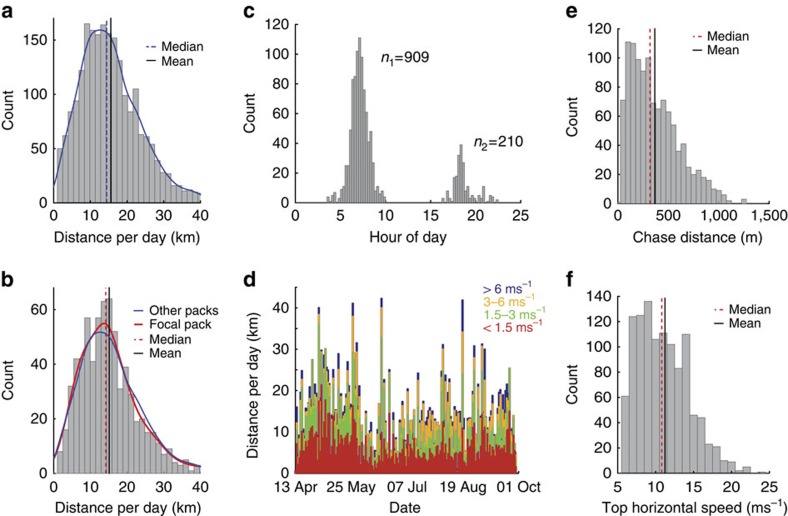
Detailed analysis of African wild dog movement.Histogram of distance travelled per day including kernel density estimate for (a) 18 dogs in 13 other packs in the area (n=2,226 dog days) and (b) for the focal pack (n=708 dog days). Abscissa is cutoff at 98th percentile. The kernel density estimate for other packs (blue line) is displayed alongside the estimate for the focal pack (red line) in b after being normalized to fit the focal pack sample size. (c) Start time for all recorded chases at local time (n=1,119). (d) Distance travelled per day in kilometres by example dog ‘MJ' colour coded into different speed ranges (walk: 0–1.5 ms−1 (red), trot: 1.5–3 ms−1 (green), slow gallop: 3–6 ms−1 (yellow), fast gallop: >6 ms−1 (blue)). (e) Total distance covered in each chase (n=1,119). (f) Top stride speed recorded in each chase (n=1,119).